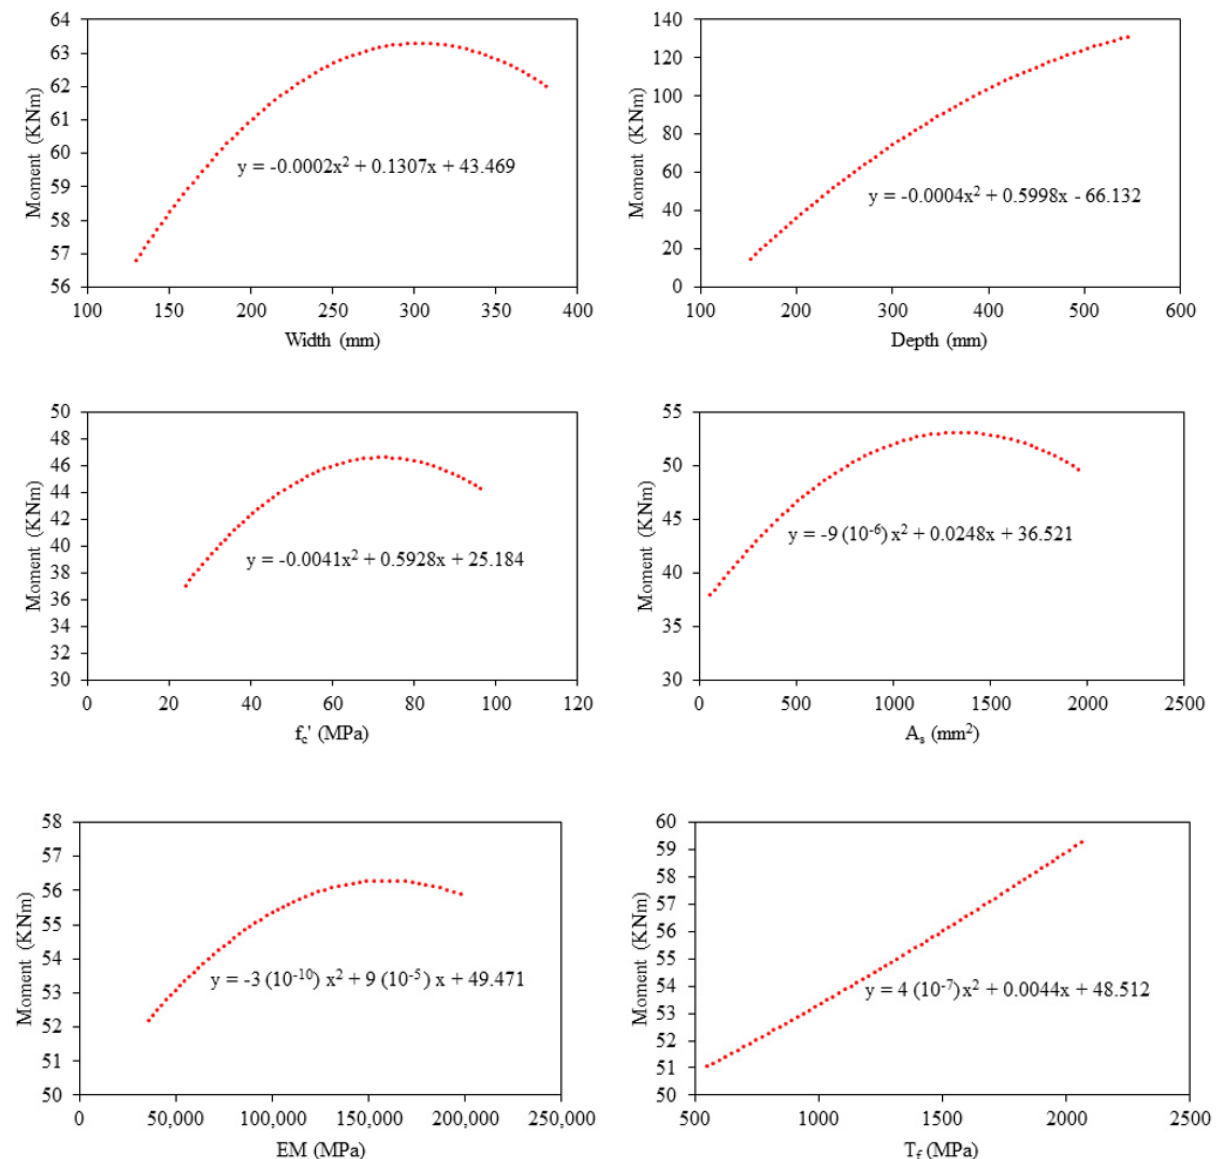
Figure 7. Parametric analysis of the input variable ( W , D , f c ’ , As , EM , T f ) against moment (M) using GBT Model.